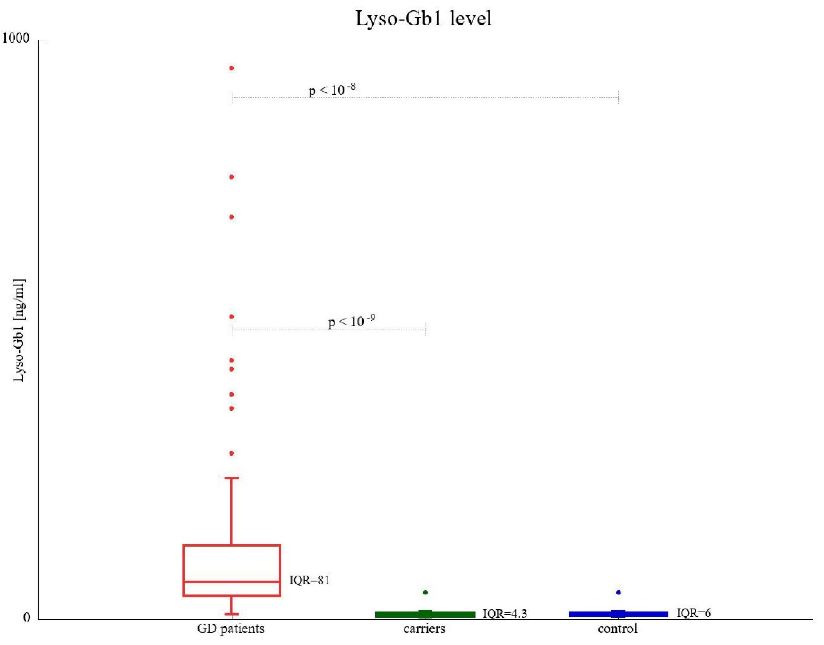
Figure 1. Lyso ‐ Gb1 concentration (ng/mL) in GD patients and GBA1 carriers compared to healthy Figure 1. Lyso-Gb1 concentration (ng/mL) in GD patients and GBA1 carriers compared to healthy control subjects. IQR represents the interquartile range. control subjects. IQR represents the interquartile range.